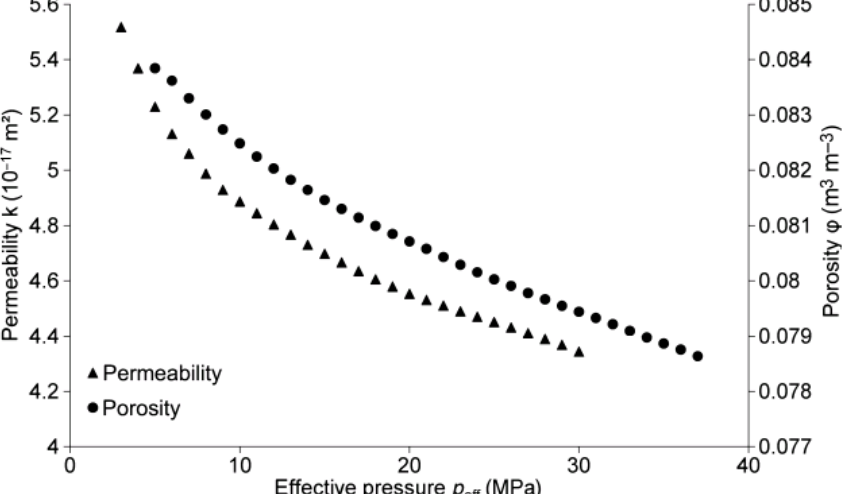
Figure 4. Decrease in measured porosity and permeability of Flechtinger Sandstone geothermal reservoir because of increased effective stress (here called effective pressure) [46].